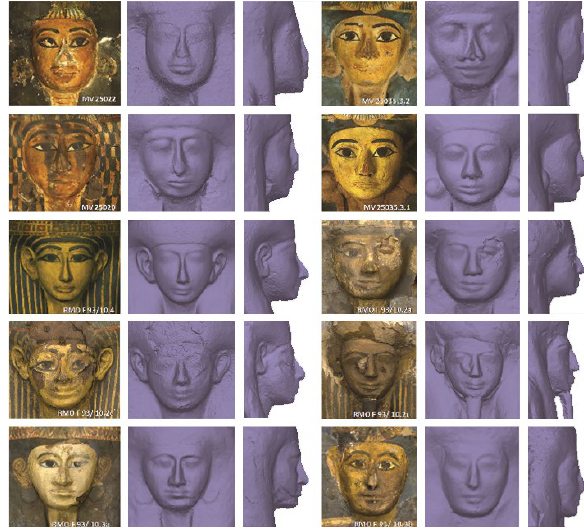
Figure 3. Comparison between textured and not textured orthophoto. Courtesy of the Vatican Coffin Project (©Musei Vaticani and Rijksmuseum van Oudheden, Leiden).